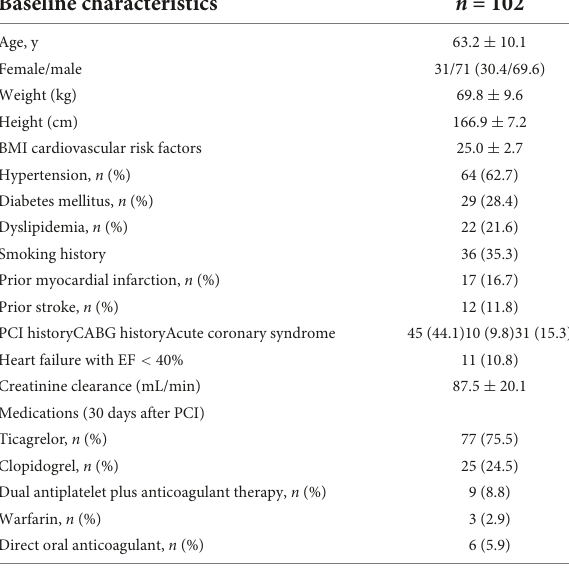
TABLE 2 Baseline characteristics of all patients.